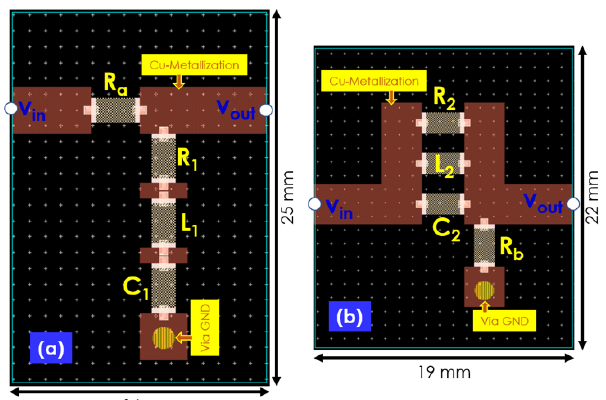
FIGURE 3. Momentum® layouts of designed (a) RLC-series and (b) RLC- parallel PoC circuits.